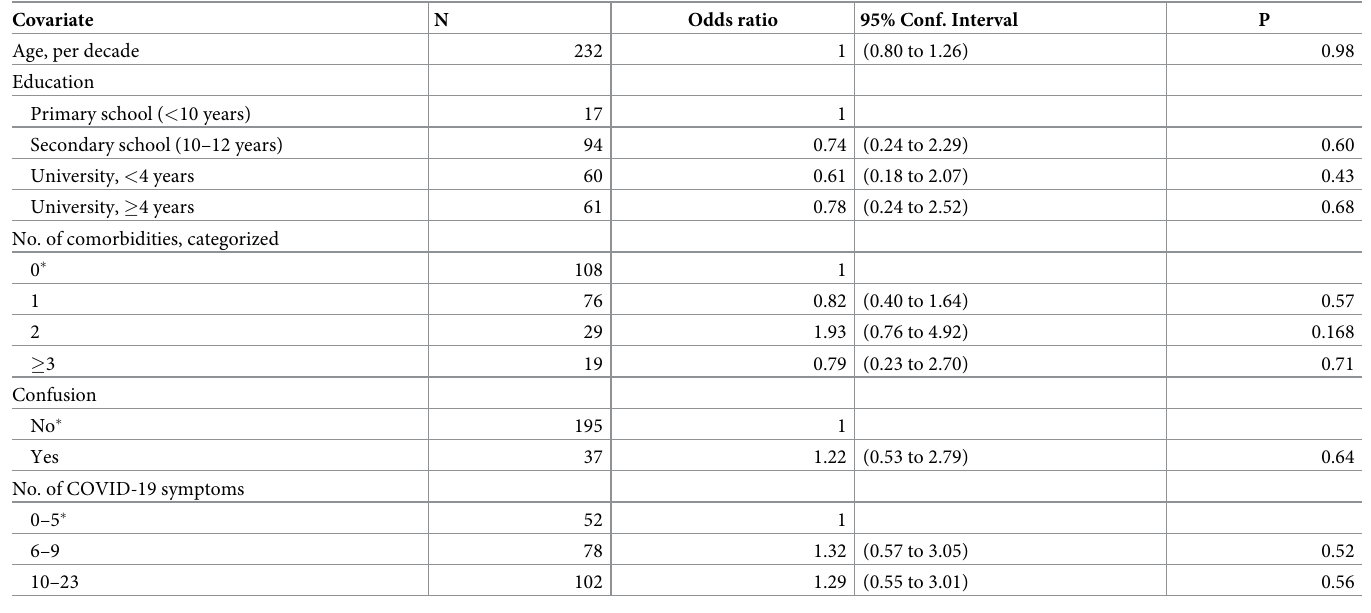
Table 4. Determinants of cognitive impairment (z-score < -1.5) in at least 1 of 4 tests. Logistic regression analysis (n = 232).